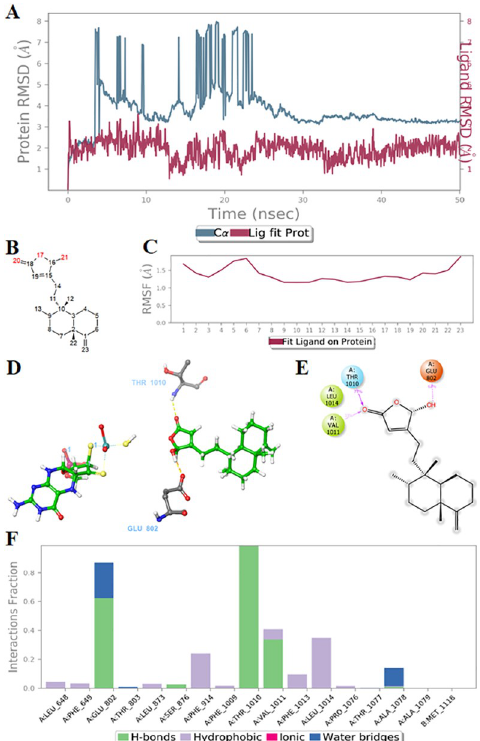
Fig 3. Molecular dynamics simulations of compound 3 –xanthine oxidase (XO) protein complex. (A) Root mean square deviation of protein (azure) and compound (red signal); (B). The number of atoms of compound 3 ; (C) Root mean square fluctuation of compound 3 fitted on the XO protein; (D) 3D molecular dynamics simulations presenting binding modes of compound 3 to Glu 802 and Thr 1010 residues of XO via two H-bonds; (E) The common interactions ( > 30.0% of the simulation time up to 50.05 nanoseconds); (F) The interaction percentage of compound 3 with surrounding residues. Green ball-and-stick: ligand; black: carbon atoms; red: oxygen atoms; blue: nitrogen atoms.